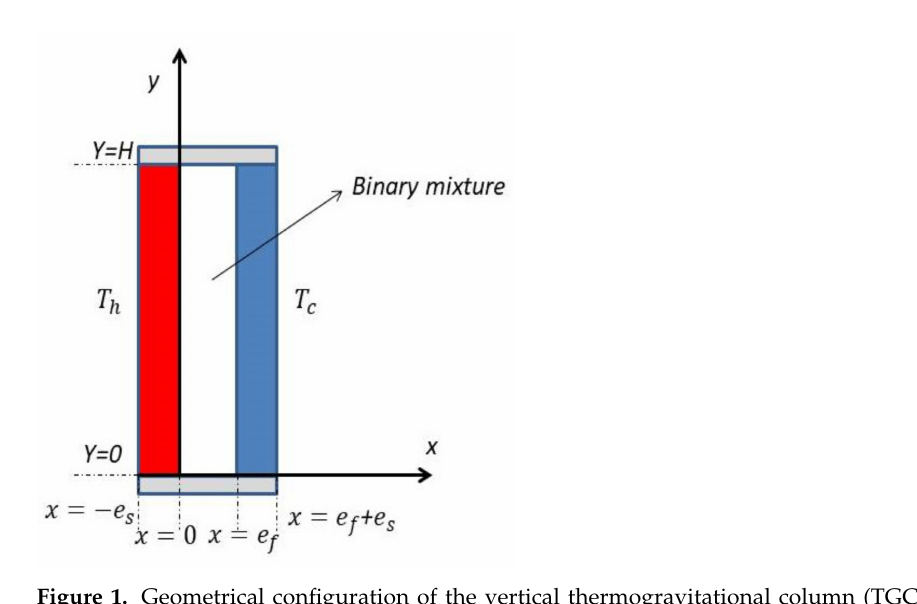
Figure 1. Geometrical configuration of the vertical thermogravitational column (TGC). See text for